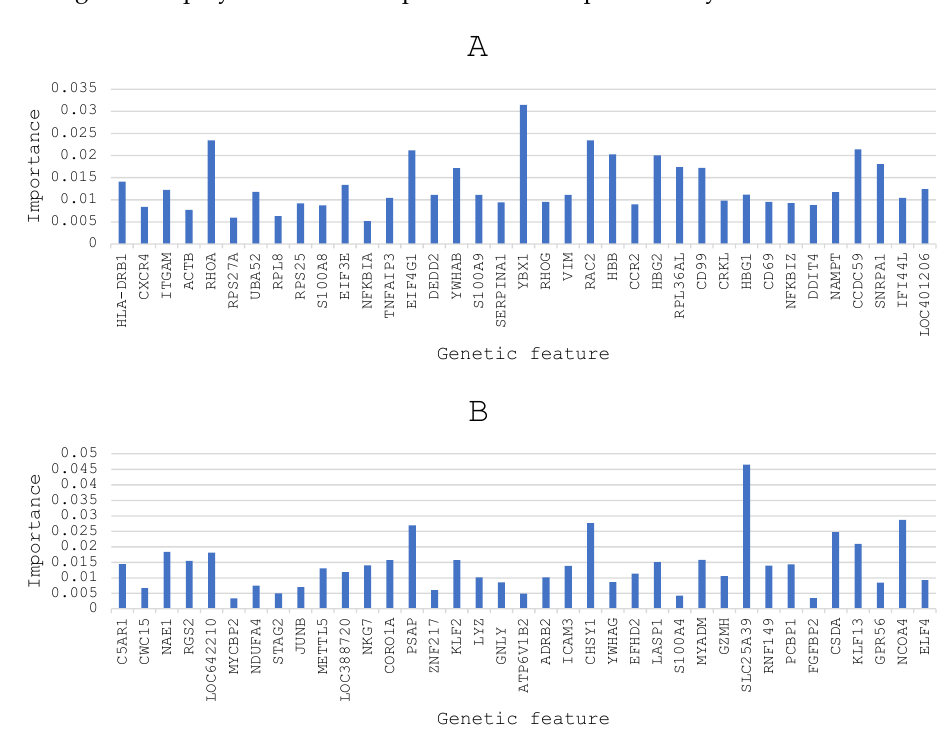
Figure 3. Feature importances; this graph presents the 74 genes divided into two blocks; ( A ): first part; ( B ): second